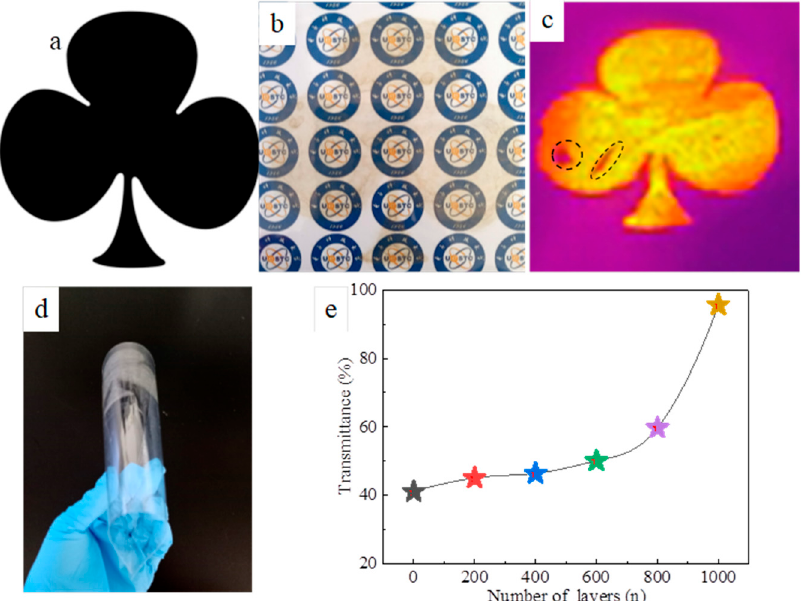
Figure 13. Designed pattern ( a ), printed pattern ( b ), infrared thermal imaging ( c ), film bending photograph ( d ), and the sheet resistance of the film in different bending cycles of outward bending ( e ). We also designed a 4 cm × 4 cm cross finger circuit pattern to print on the surface of the PET using AgNWs ink. After drying, the cross finger circuit pattern and the light emitted diode (LED) bead were assembled into a circuit. Figure 14 shows the designed